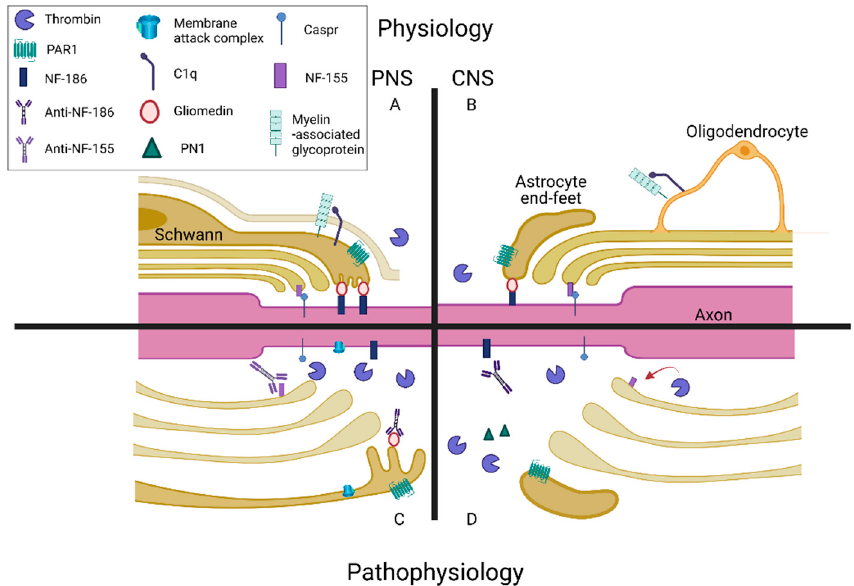
Figure 3. Complement and coagulation cascade neuroinflammatory effects on the node of Ranvier (NOR): ( A ) Peripheral nervous system (PNS) NOR: Schwann cells express protease-activating receptor 1 (PAR1) at the microvilli. Neurofascin-186 (NF-186) interacts with gliomedin in the matrix and in the microvilli to promote axon–Schwann cell microvilli attachment. Neurofascin-155 (NF-155), a paranodal protein, acts as a cell adhesion molecule between axons and myelin. In physiological conditions, complement and coagulation factors are downregulated in the PNS. C1q is bound to myelin-associated glycoprotein (MAG), a transmembrane glycoprotein localized in Schwann cells and oligodendrocytes. ( B ) Central nervous system (CNS) NOR: Normal myelin thickness and gaps at the NOR are mediated by astrocyte exocytosis. PAR1 is localized on the cell body and astrocytic endfeet. Thrombin is generated by neuronal and glial cells. ( C ) PNS NOR pathology: Complement activation and membrane attack complex (MAC) formation are upregulated in pathophysiological conditions. MAC mediates the cell-killing effect of the complement cascade. The NOR is a primary site of immune attack. Anti-NF186 and NF-155 antibodies have been found in PNS demyelinating disorders. In the PNS, thrombin levels increased in diseased states. NOR morphology was damaged and nerve conduction velocity was impaired. ( D ) CNS NOR pathology: A plausible role of the complement system as a part of the coagulation–inflammation interface is suggested. Thrombin proteolysis of NF-155 has negative effects on axonal conduction. Inhibitors of thrombin activity such as protease nexin 1 (PN1) are locally expressed in the brain. Perinodal astrocytes regulate this mechanism